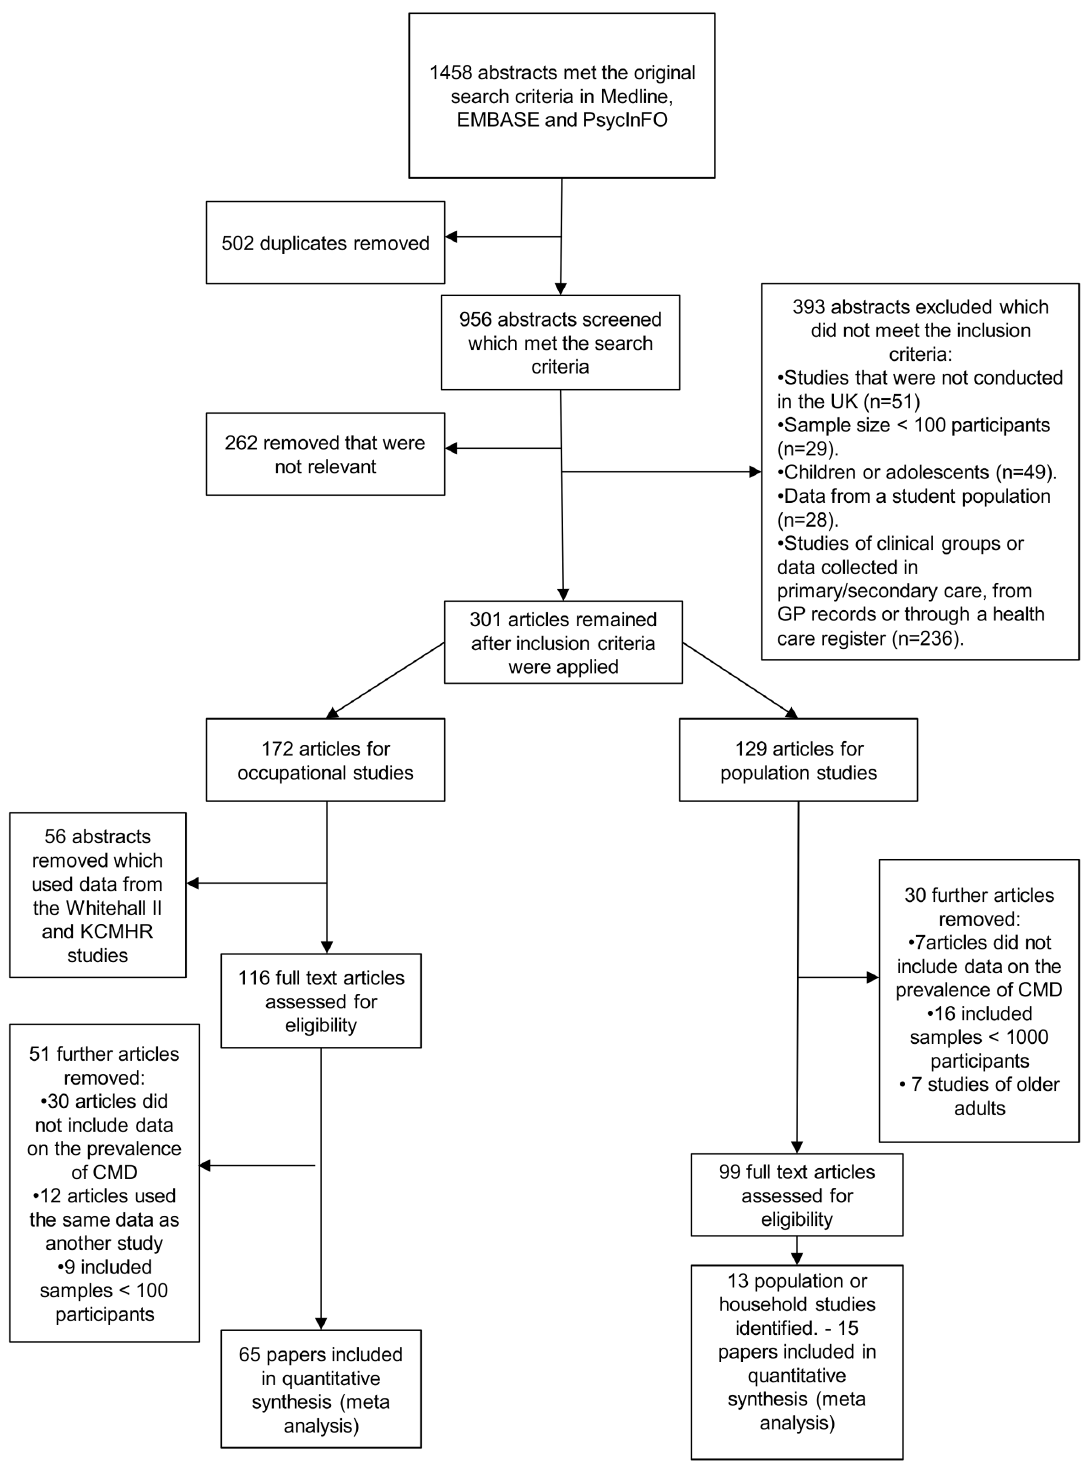
Figure 1. PRISMA flow diagram showing the search process and selection of relevant abstracts.